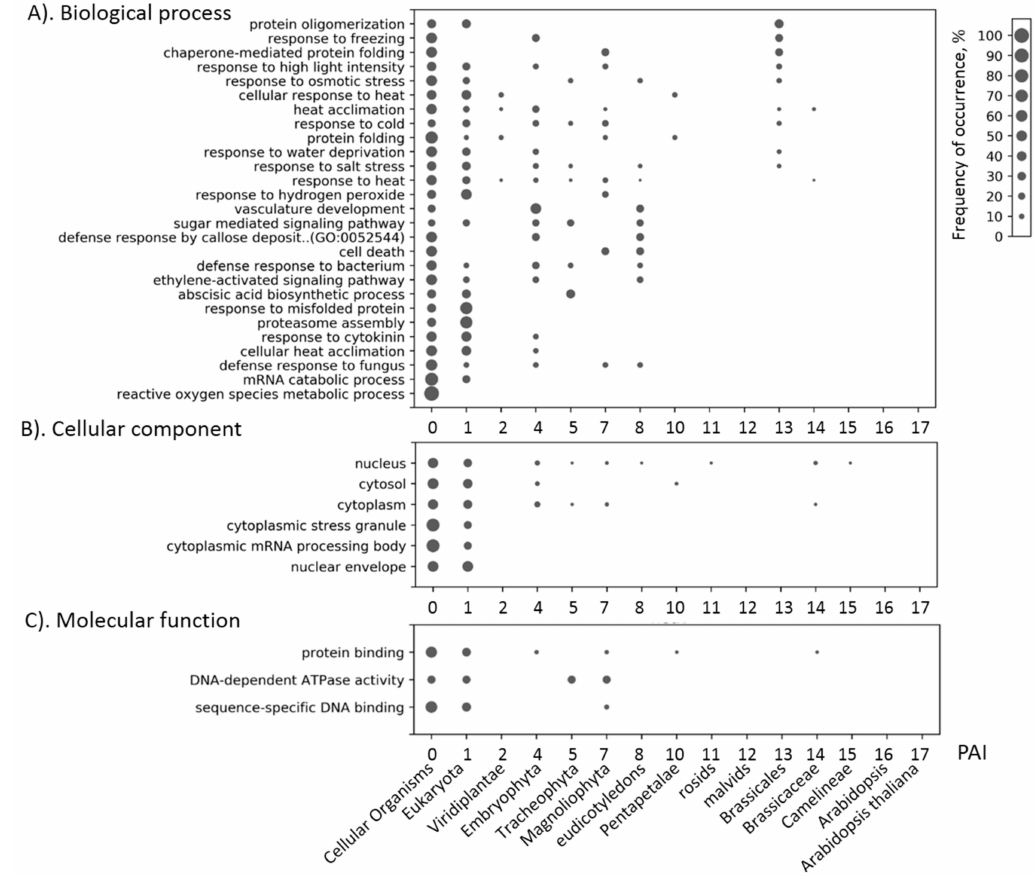
Figure 6. PAI distribution for genes associated with the heat stress and annotated by various GO terms: ( A ) GO terms for “biological process”; ( B ) GO terms for “cellular component”; GO terms for “molecular function”. The frequency of PAI occurrence is normalized to 100% for each GO term and shown by circles. The scale of circles shown on the